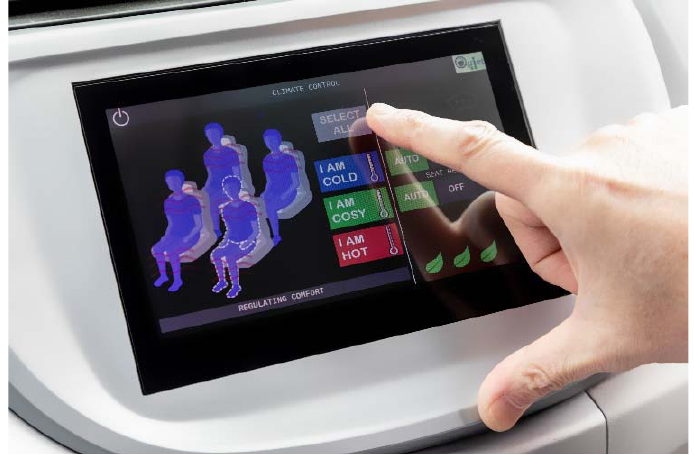
Figure 2. Detail of the touchscreen HMI [23]. Image © Honda R&D Europe (Deutschland)